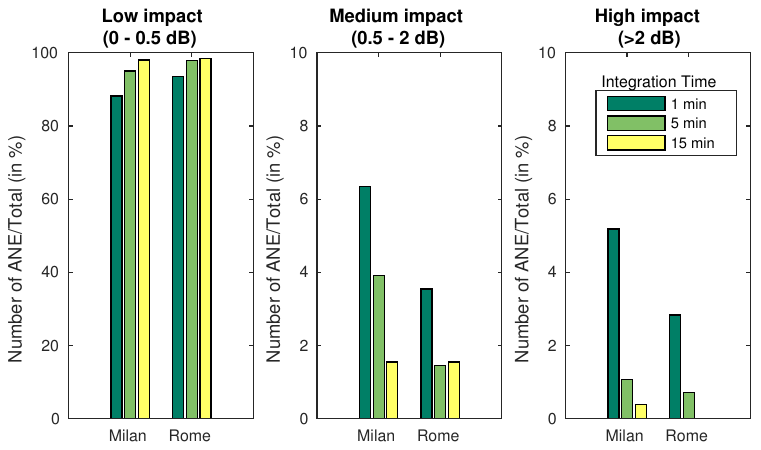
Figure 5. Distribution of the individual ANEs according to their impact on the L Aeq computation for the urban (Milan) and suburban (Rome)